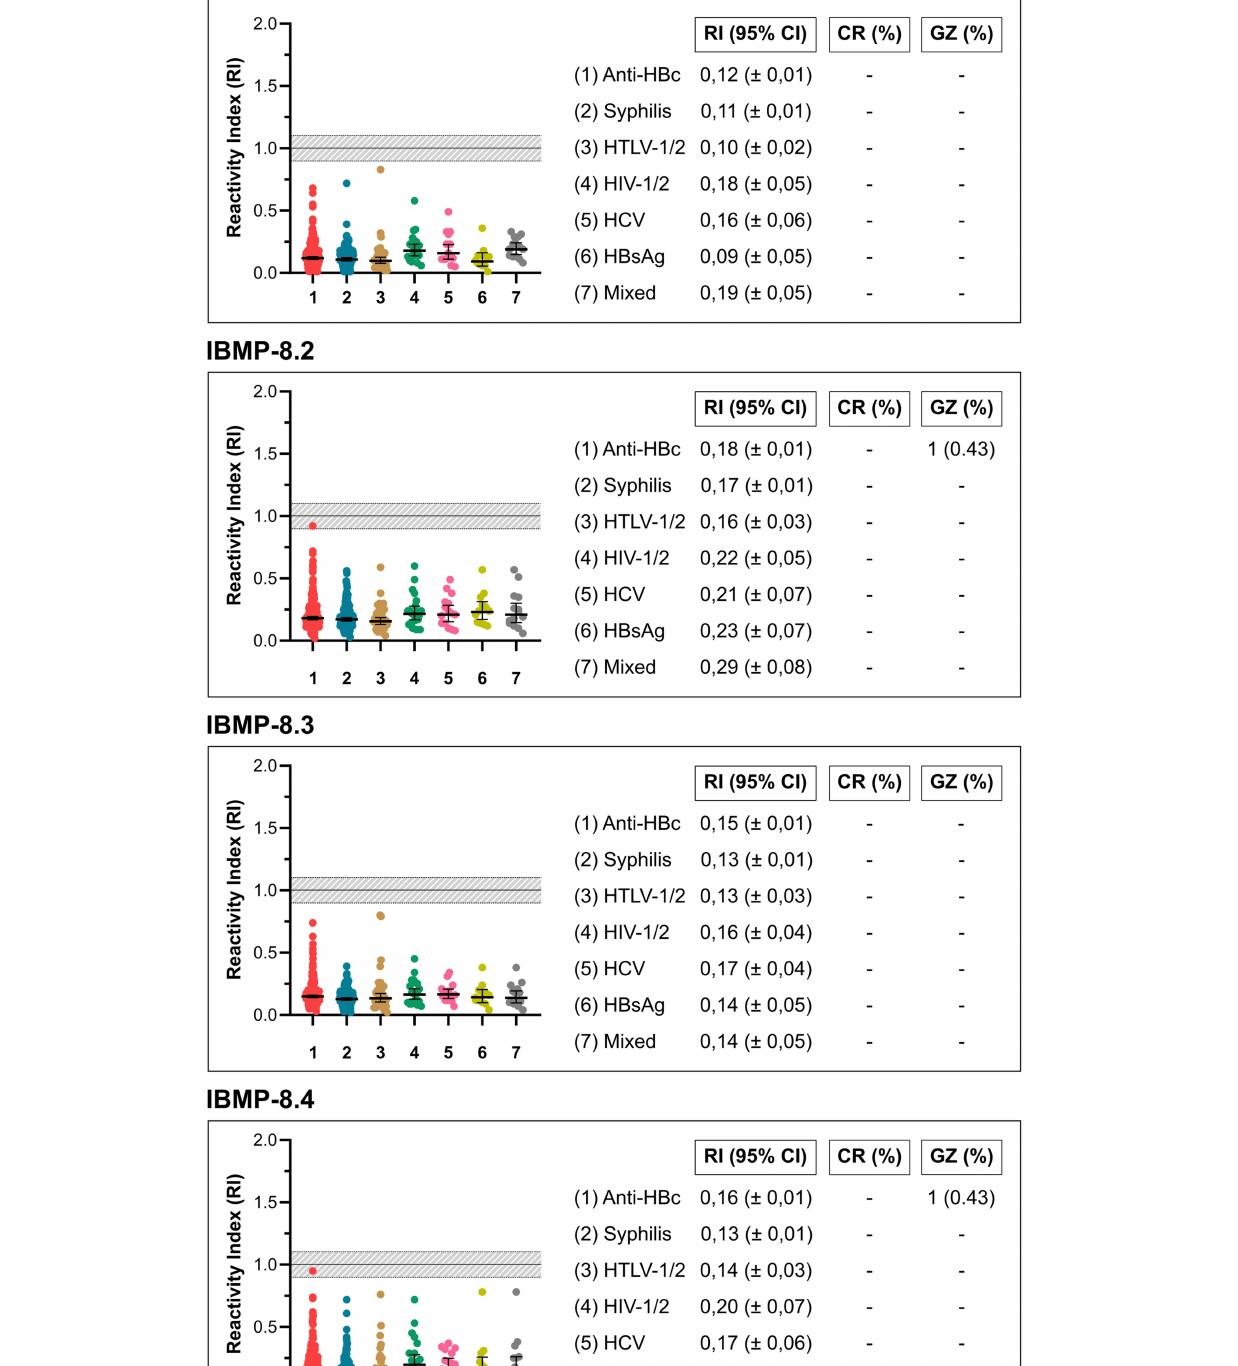
Frontiers in Medicine |